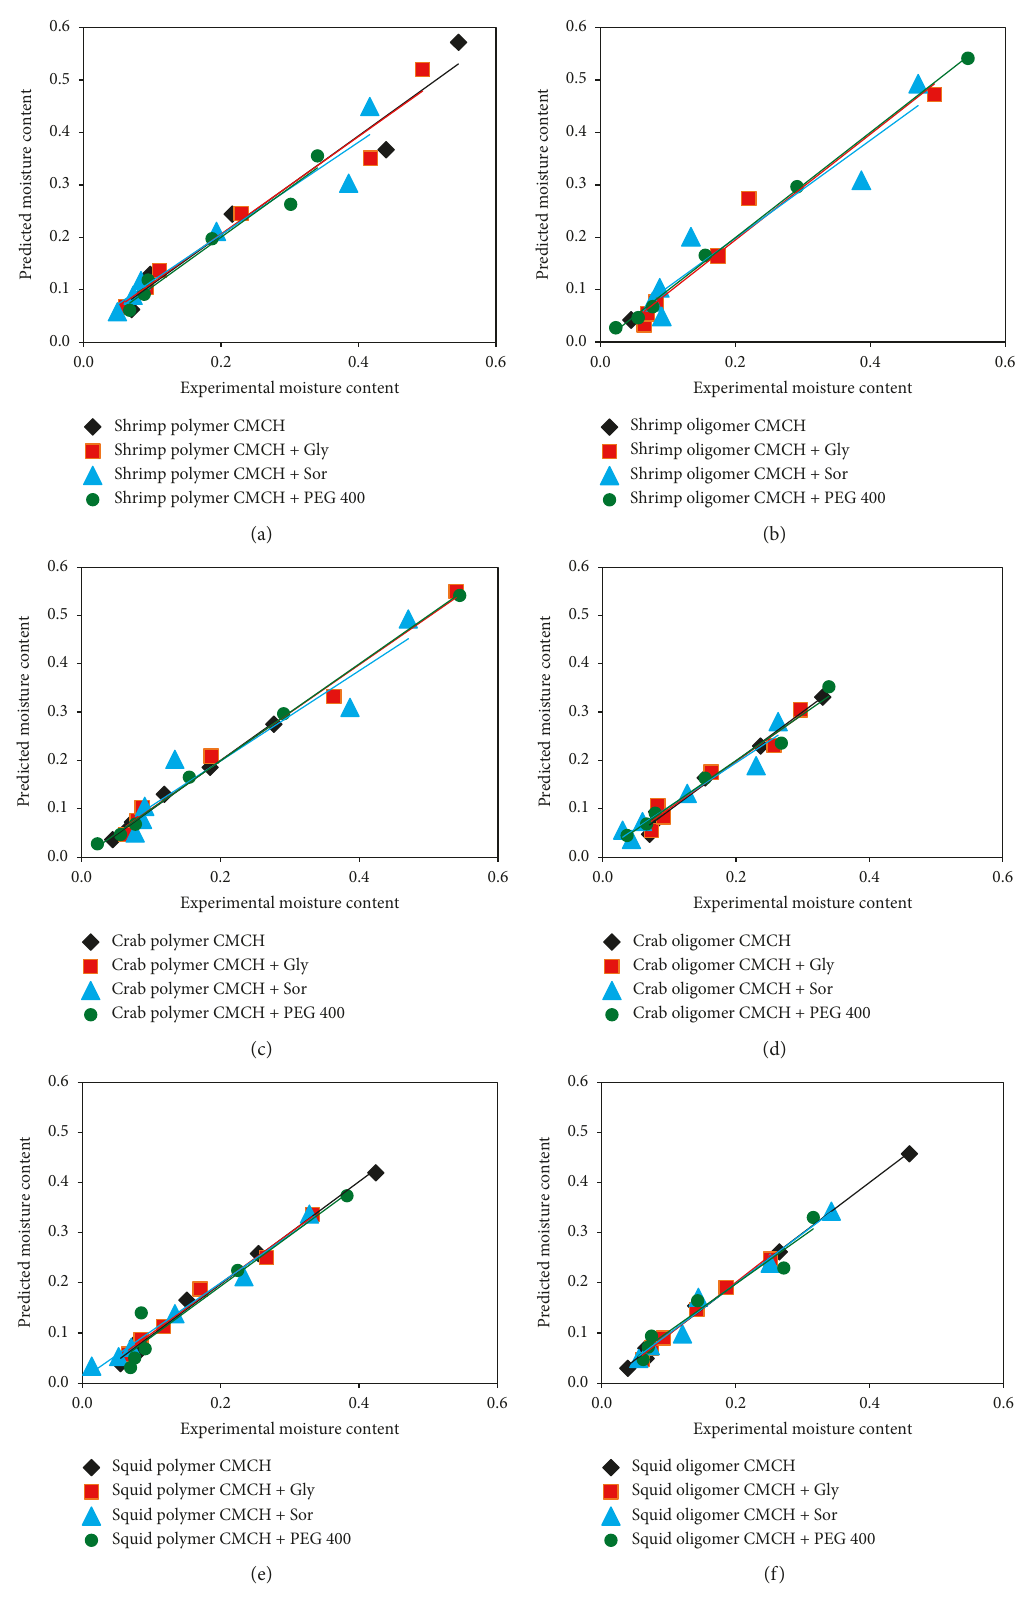
Figure 7: The comparison between the experimental moisture content values and those predicted for all the CMCH films from the BET model: shrimp polymer CMCH films (a); shrimp oligomer CMCH films (b); crab polymer CMCH films (c); crab oligomer CMCH films (d); squid polymer CMCH films (e); squid oligomer CMCH films